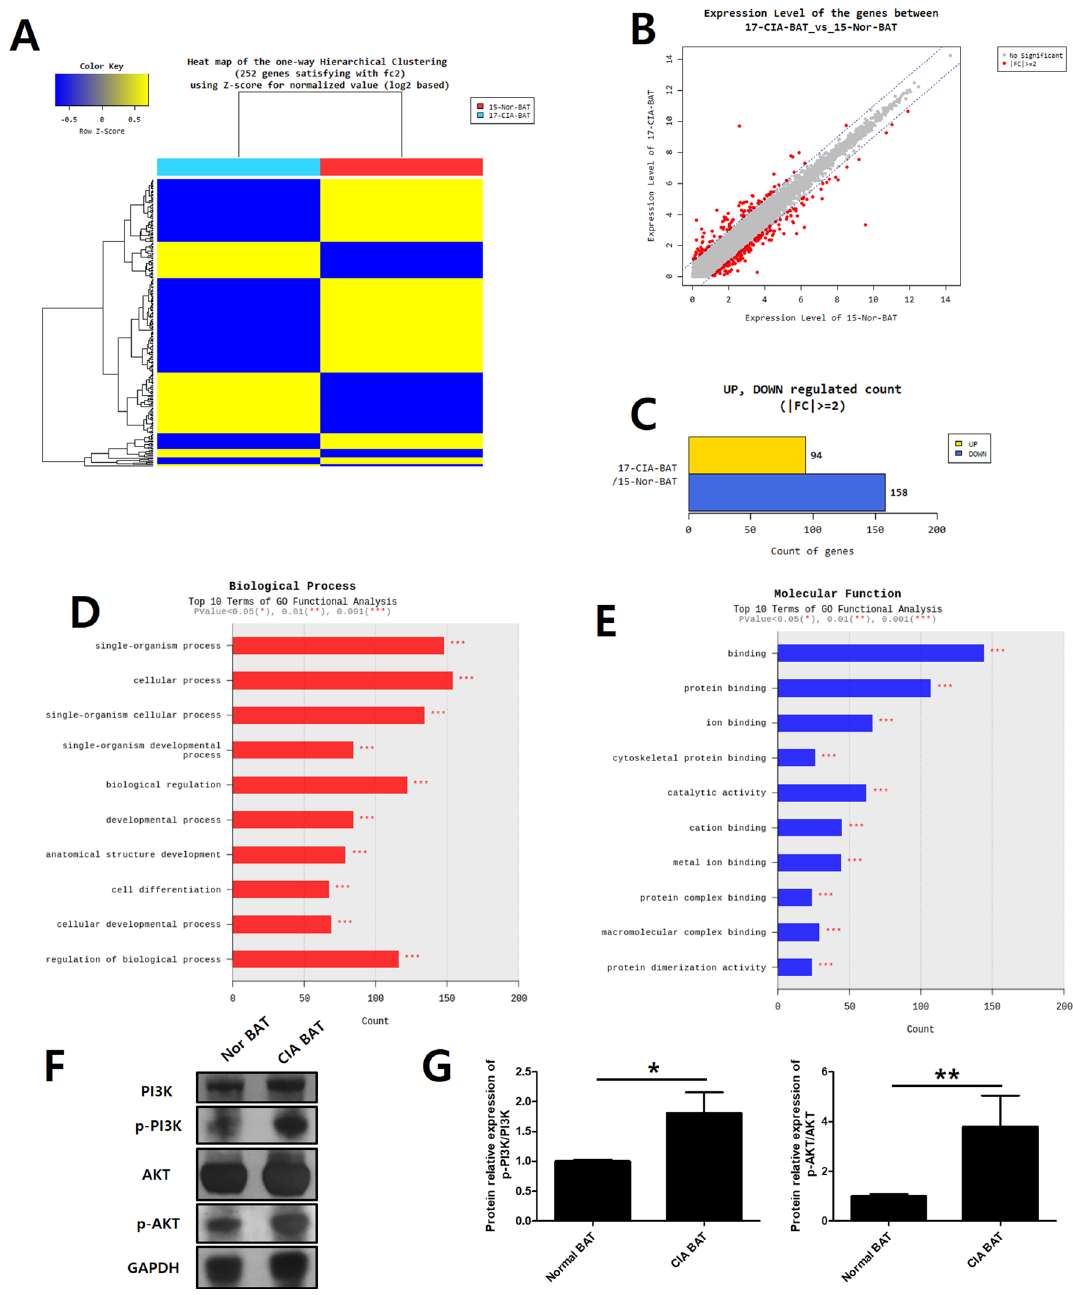
Figure 5. Comparison of gene expression between normal BAT and CIA BAT in mice by microarray analysis. ( A ) Hierarchical cluster heatmap of normal BAT and CIA BAT. ( B ) Scatter plots of the expression levels of genes between normal BAT and CIA BAT. ( C ) Significantly different gene numbers are shown in normal BAT and CIA BAT. ( D , E ) Top 10 biological processes and molecular functions associated with upregulated and downregulated genes in normal BAT and CIA BAT, based on gene ontology functional analysis. ( F ) The relative expression levels of total PI3K (PI3K), phosphorylated PI3K (p-PI3K), total AKT (AKT) and phosphorylated AKT (p-AKT) proteins were determined by western blotting. ( G ) The protein expression levels which were the ratio of the phosphorylated protein/total protein values of PI3K and AKT were monitored. *P < 0.05, **P < 0.01, and ***P <